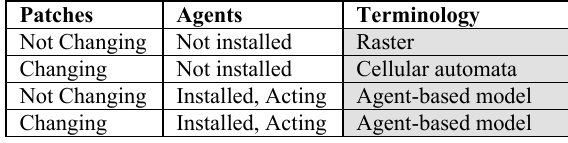
Table 1. Modelling ways, interaction is always possible between patches and